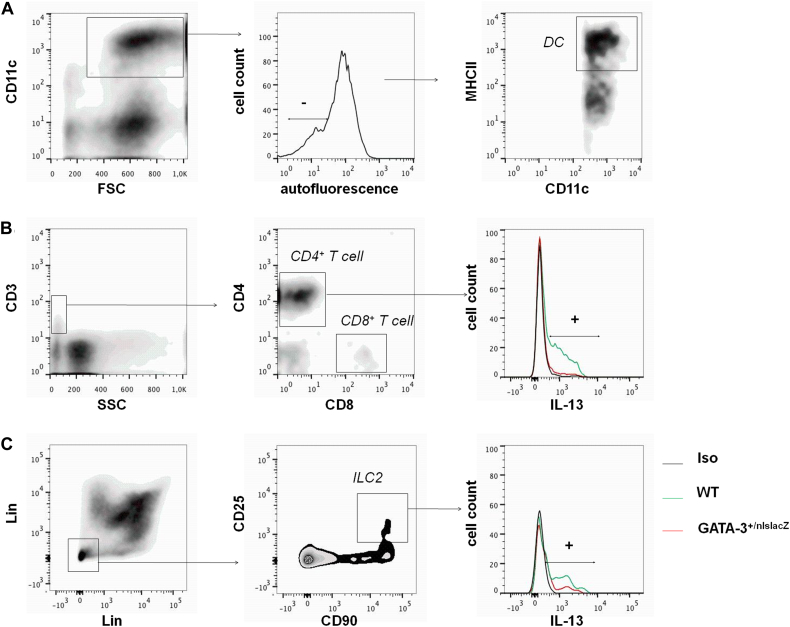
Representative density plots and gating strategy of all analyzed cell populations in BALF. WT mice were exposed to 25 μg of DEPs plus 1 μg of HDM. A, DCs were gated as CD11chigh, low autofluorescent, and MHCII+. B, CD4+ T cells were CD3+, CD4+, and CD8−. CD8+ T cells were characterized as CD3+, CD4−, and CD8+. Intracellular IL-13 production of CD4+ T cells was investigated. C, ILC2s were identified as Lin− (CD3−, CD5−, NK1.1−, TCRβ−, CD11c−, CD11b−, and CD45R−), CD25+, and CD90+ cells. Intracellular IL-13 production of ILC2s was investigated. FSC, Forward scatter; SSC, side scatter.